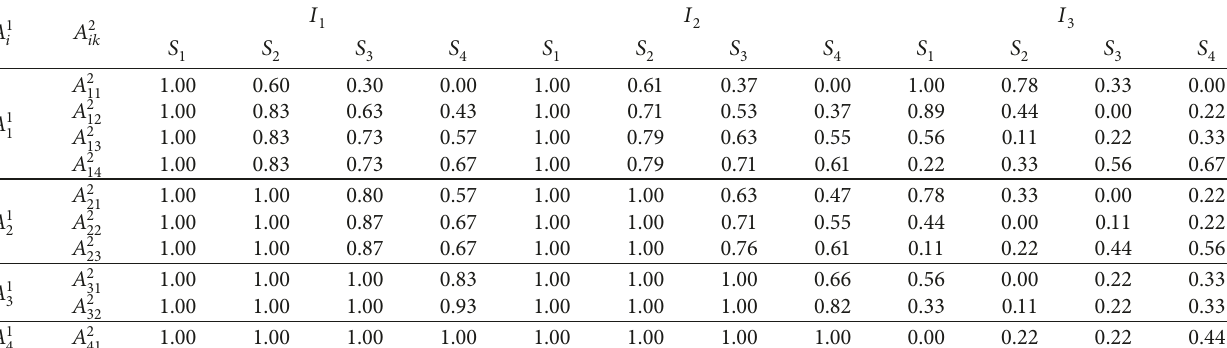
Table 3: Comprehensive utility of conducting responding measure A 2 ik for scenario